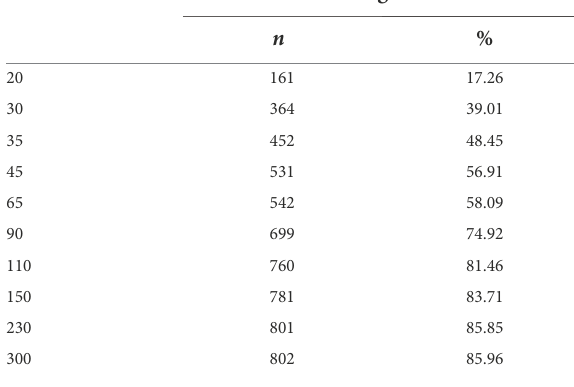
TABLE 3 Distribution of participants in the sample ( N = 933) who decided to take the gamble on the risk aversion task separately for each of the 10 items/gain